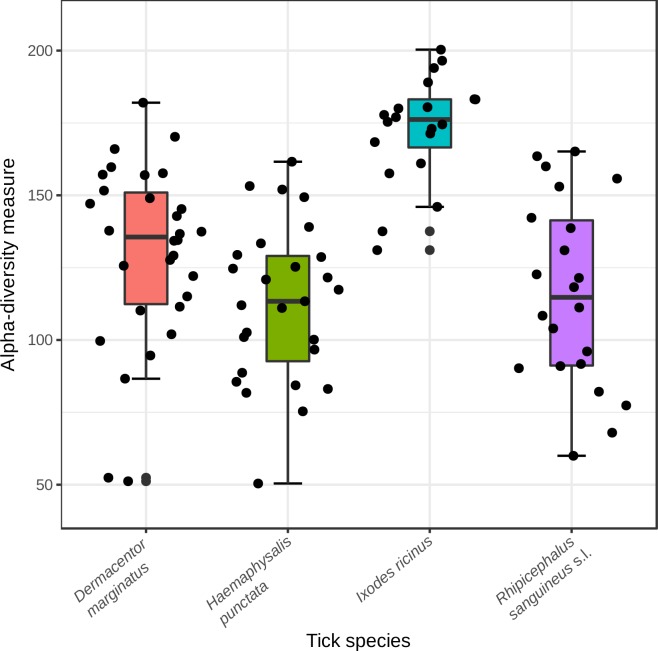
Chao1 alpha diversity index showing differences among tick species.